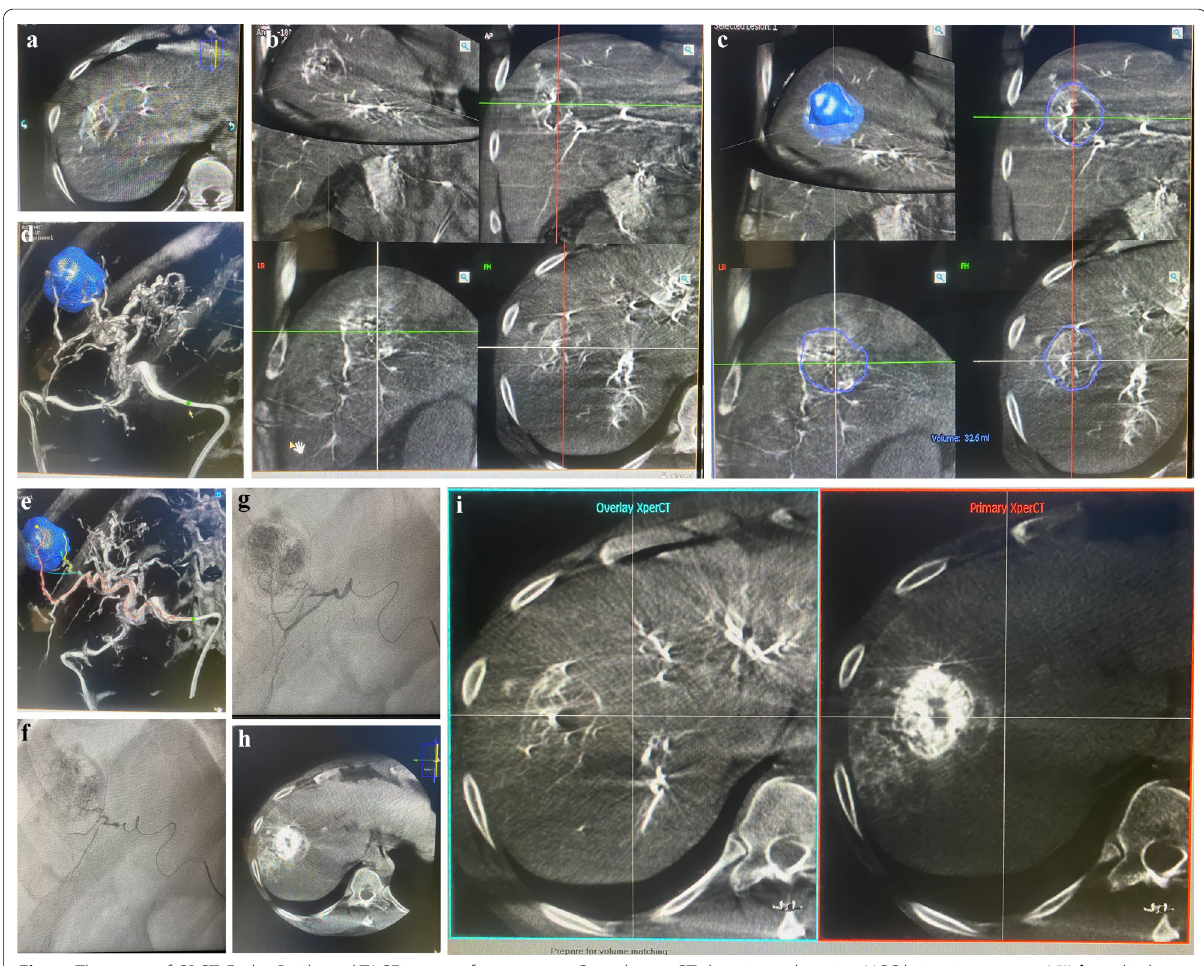
Fig. 1 The steps of CBCT, EmboGuide and TACE in one of our cases. a Cone-beam CT showing enhancing HCC lesion in segment VIII, b multiplanar image centered on the lesion. c Placing circular regions-of-interest (ROIs) for the lesion. d Placing a green dot at the tip of the catheter (arrow). e The software marked two arterial feeders colored in green and red. The green feeder gives a main branch (yellow) which gives smaller branches at the lesion site. The red feeder gives a small branch at the lesion site. f Fluoroscopic image with the tip of the microcatheter at the tip of the first feeder (marked green in the previous image) with injection of a mixture of Lipiodol and chemotherapy. g Fluoroscopic image showing the mixture of Lipiodol, and chemotherapy being injected in the second feeder (marked red in the previous image). h Completion CBCT showing the HCC completely embolized. i Comparison done by the machine software between the pre- and post-embolization CBCT to assure complete embolization of the lesion